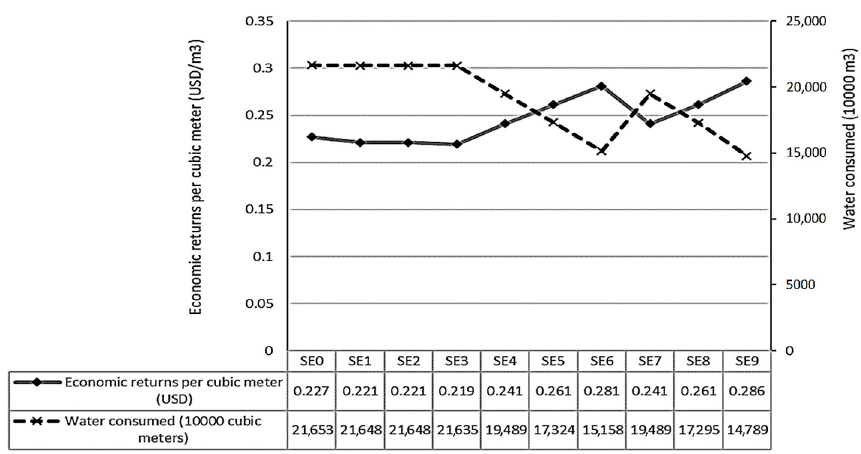
Figure 5. Comparing economic return per water (USD/m 3 ) and water consumption (10,000 m 3 ) under different scenarios.